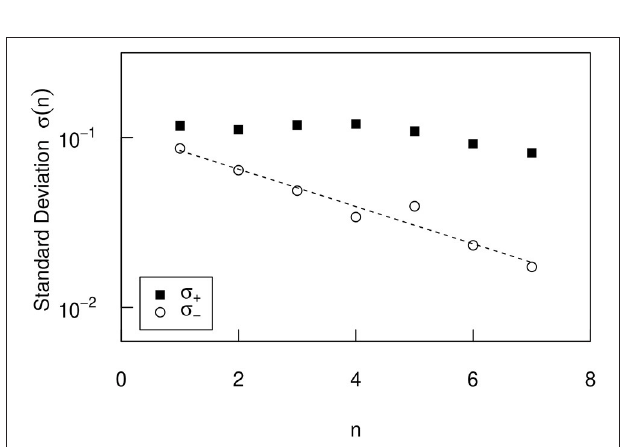
FIGURE 5 | The n dependence of the positive and negative standard deviations σ ± of the conditional PDFs in the United States ( Figure 4 ).